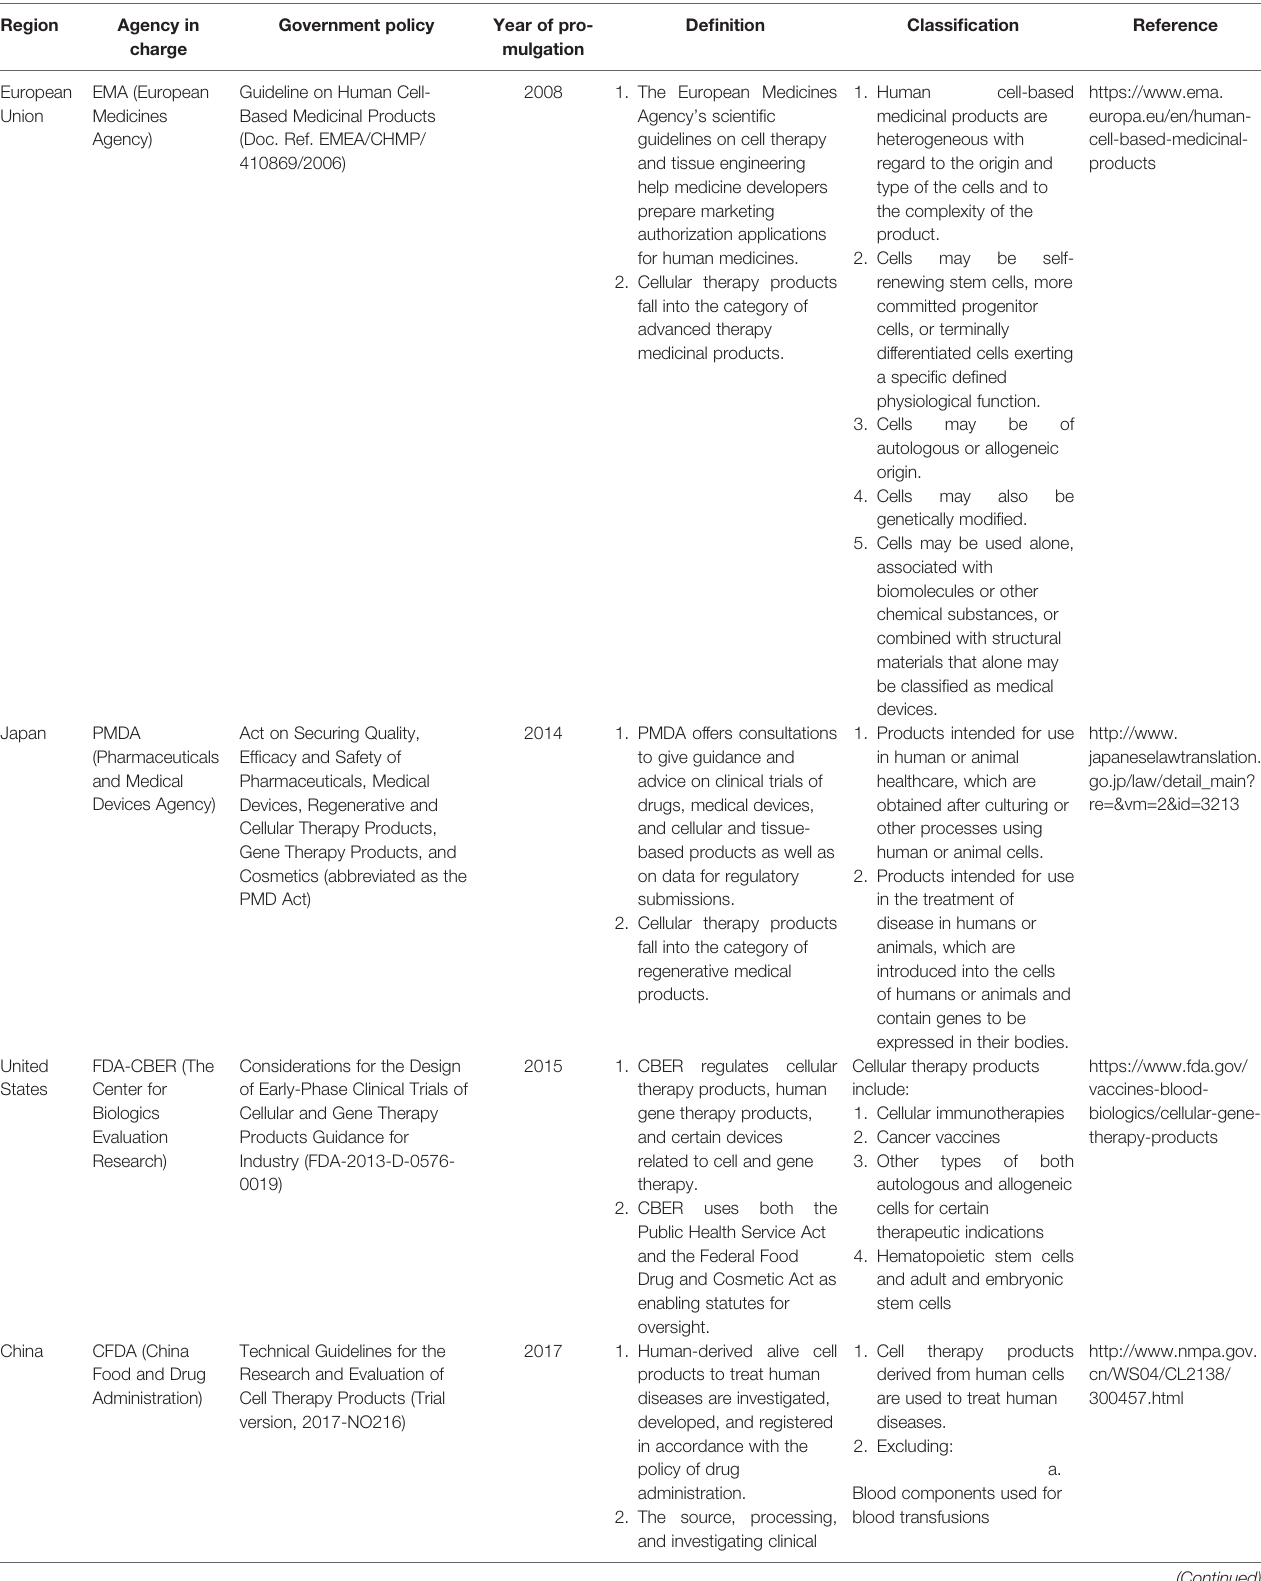
TABLE 1 | Government policies regarding cell therapies